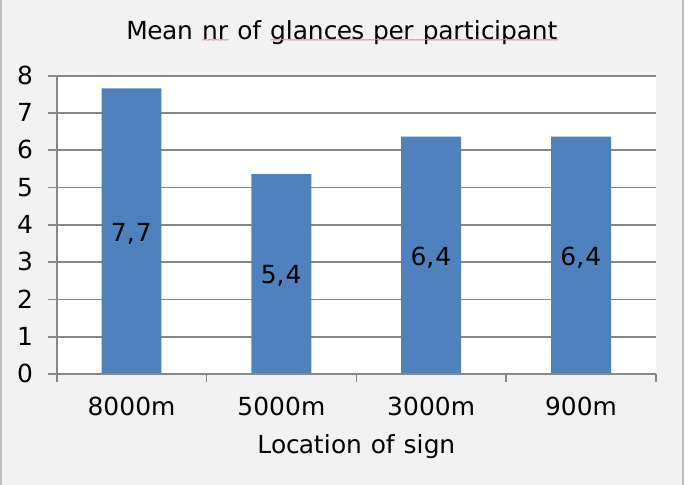
Figure 7. Number of glances at announcement